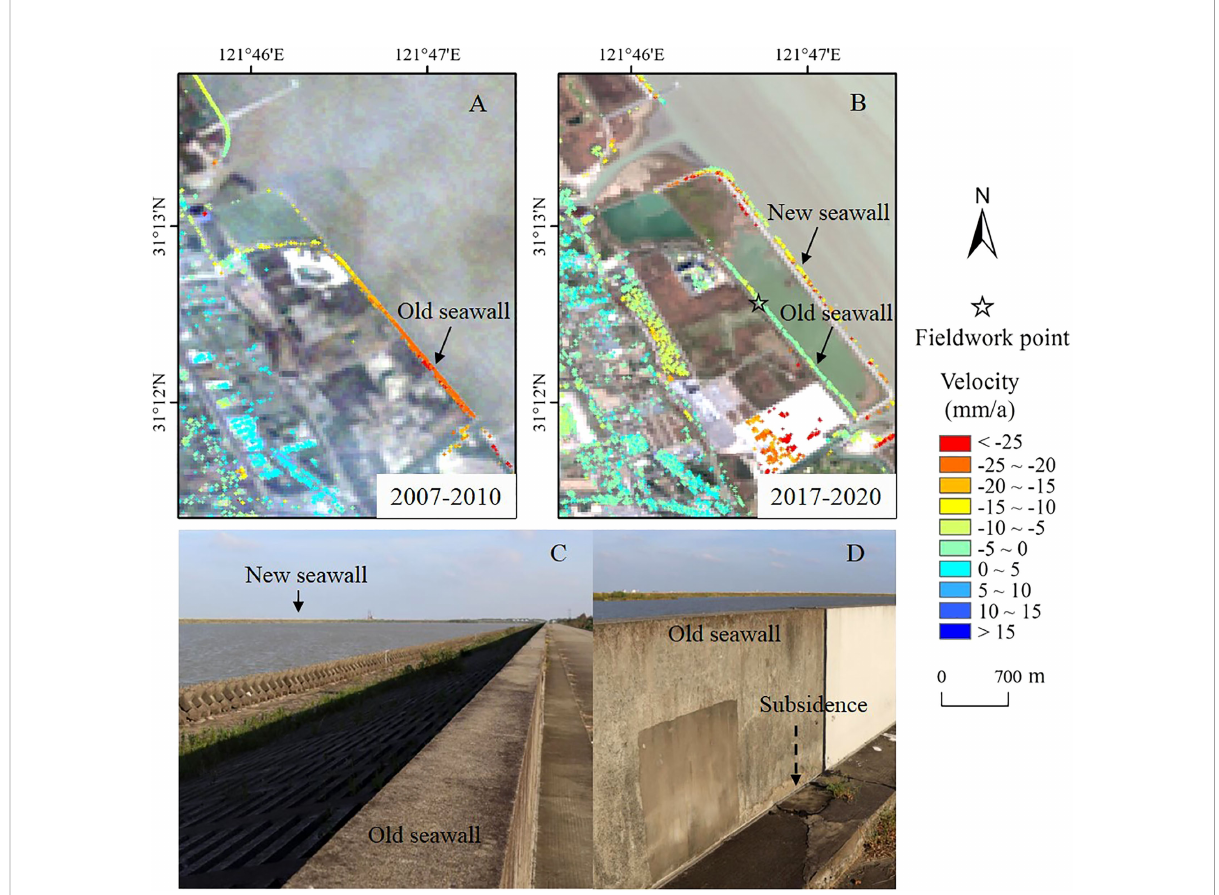
FIGURE 13 Comparison of land subsidence between old and new seawalls in different periods. Land subsidence velocity maps (A, B) are superimposed on Landsat 5 and Landsat 8 images of the area in 2010 and 2020, respectively. (C) shows the fi eld photograph of the seawalls, while (D) displays a ground breakage restoration of the old